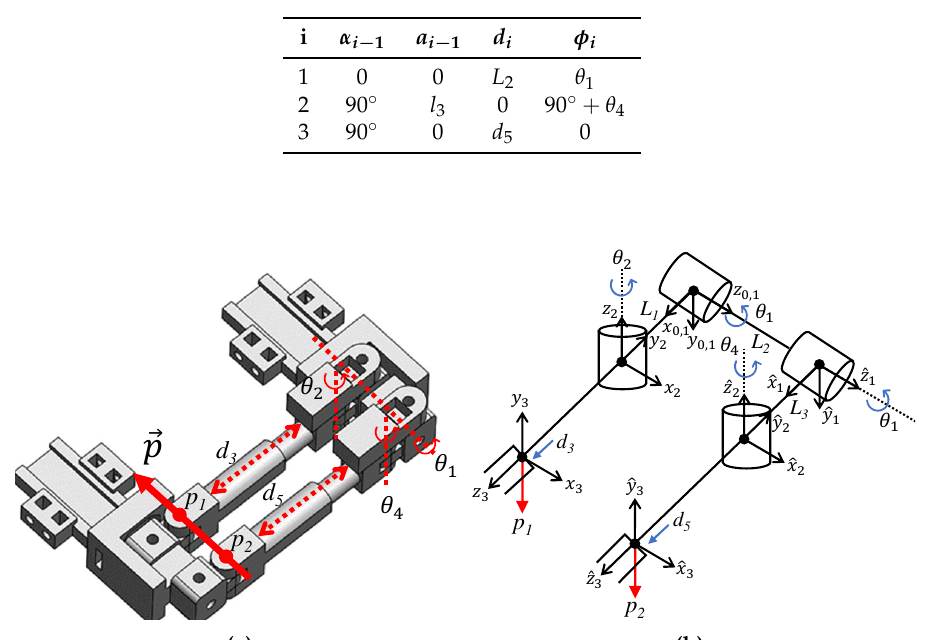
Figure 7. DH parameter of CMC joint structure; ( a ) System joints; ( b )